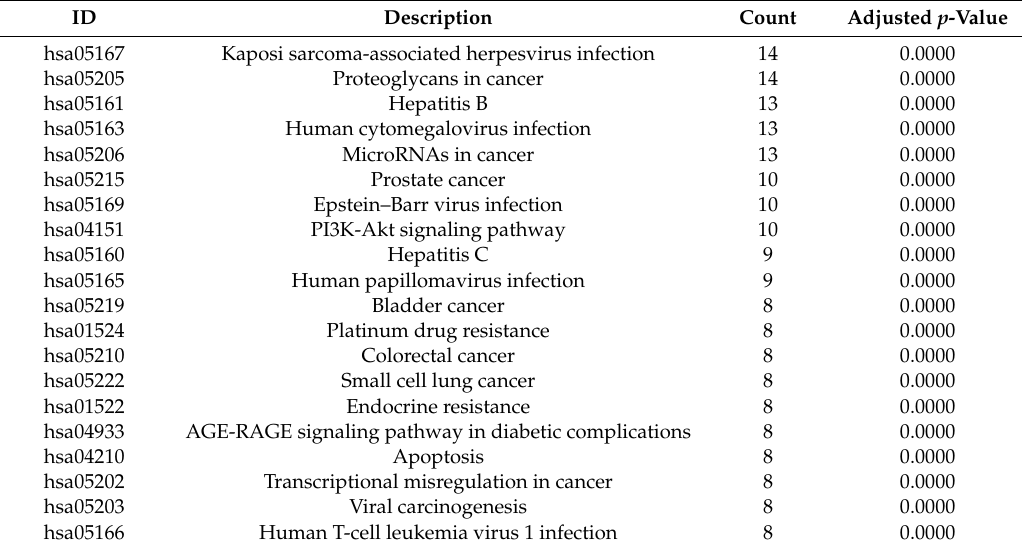
Table 4. Kyoto Encyclopedia of Genes and Genomes (KEGG) enrichment results.